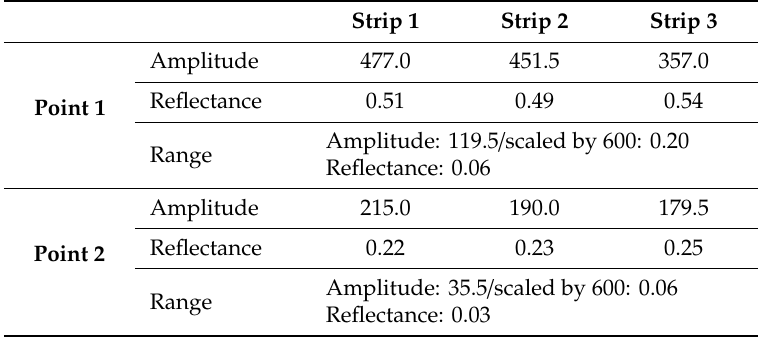
Figure 9. Histogram of di ff erences of two strips. Red: Amplitude scaled by 600. Blue: Reflectance. Table 2. Amplitude and calibrated reflectance values for points shown in Figure